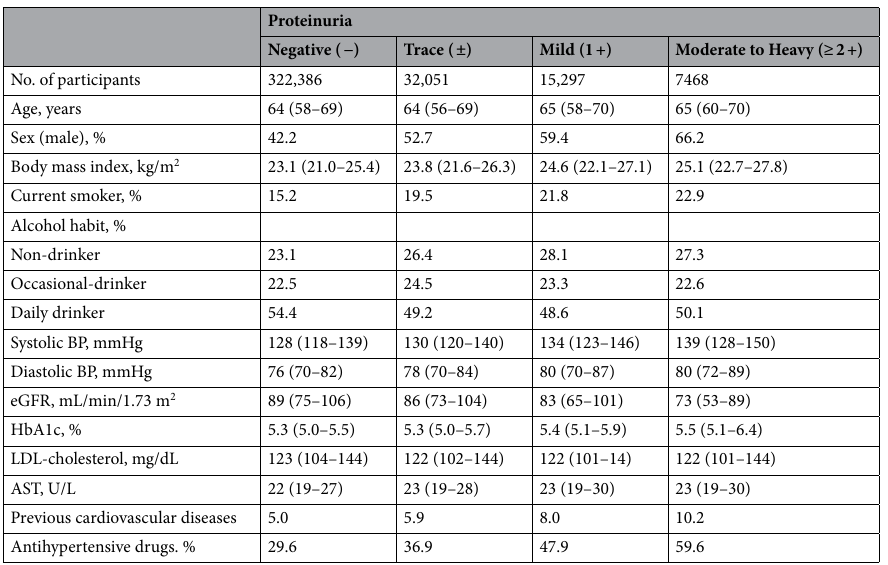
Table 1. Baseline parameters according to level of proteinuria. Data are presented as median (interquartile range) or n (%). Abbreviation: AST, aspartate aminotransferase; BP, blood pressure; eGFR, estimated glomerular filtration rate; HbA1c, glycated hemoglobin; LDL, low-density lipoprotein.